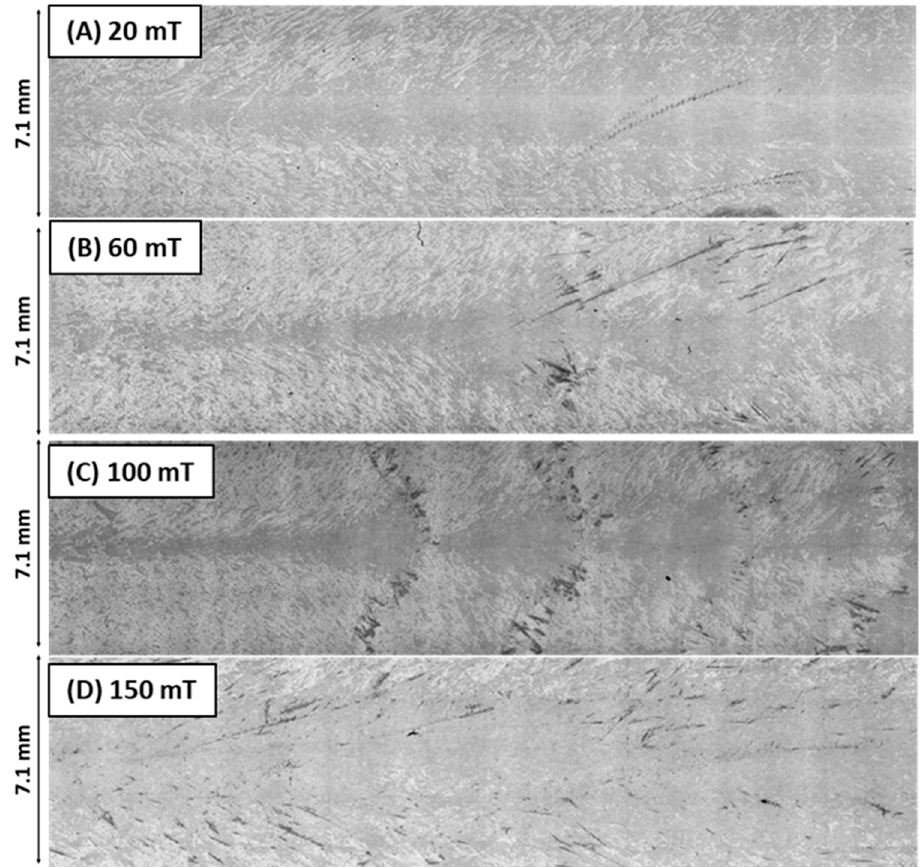
Figure 5. Macrostructures of solidified samples during step 2 of the solidification experiments (M = 50×); ( A ) step 2 of sample A, when 20 mT magnetic induction was applied. ( B ) step 2 of sample B, when 60 mT magnetic induction was applied. ( C ) step 2 of sample C, when 100 mT magnetic induction was applied. ( D ) step 2 of sample D, when 150 mT magnetic induction was applied.